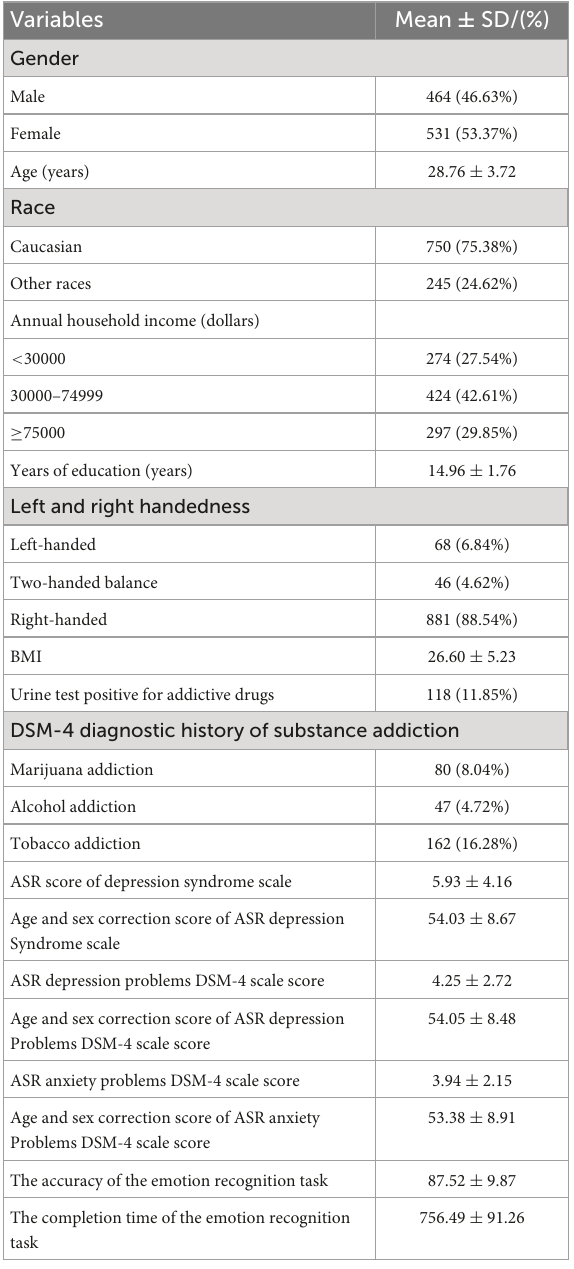
TABLE 1 Demographic and phenotype data characteristics ( n =